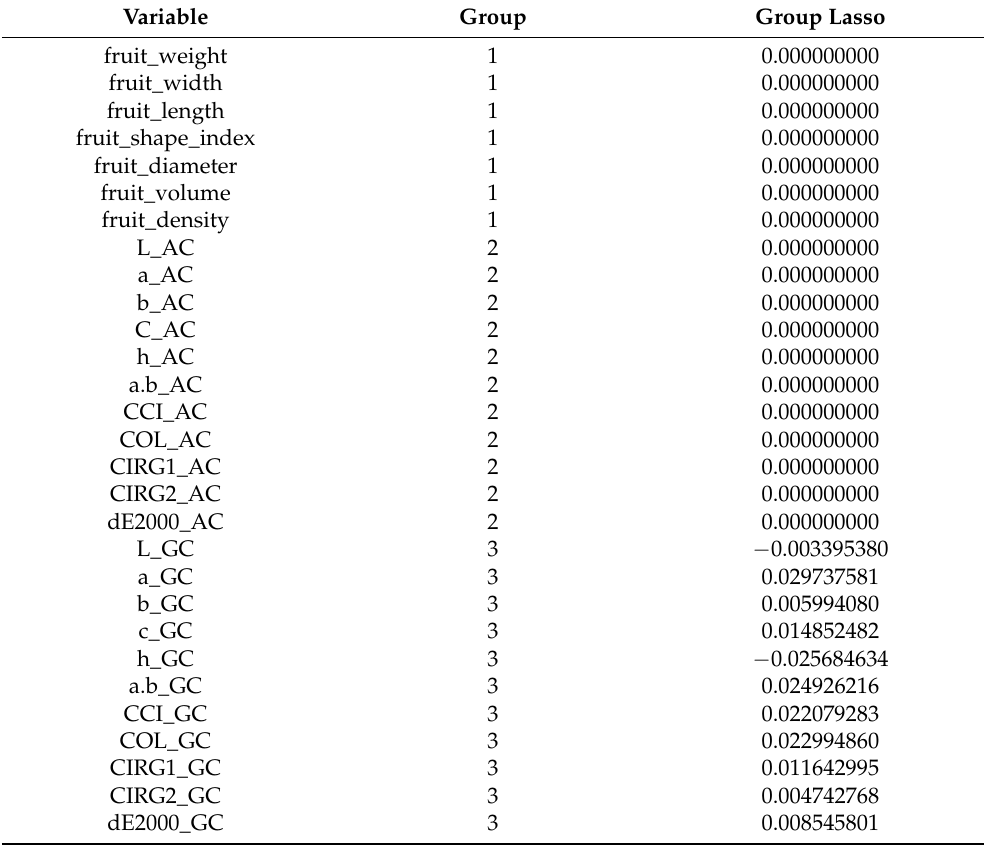
Table 2. Group LASSO regularization preserving the coefficients next to the variables in Group